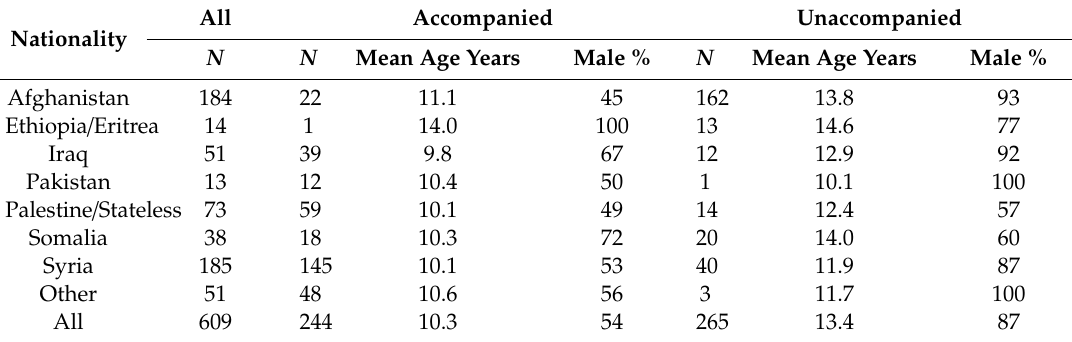
Table 1. Characteristics of the study population of school-age refugees.